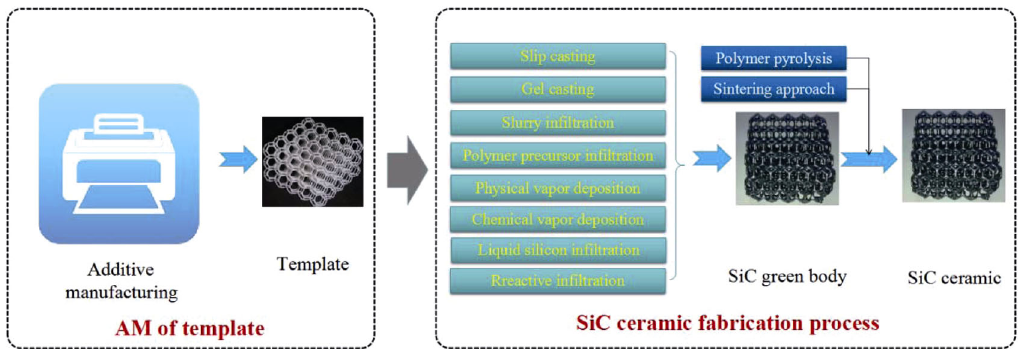
Fig. 4 Indirect additive manufacturing of SiC